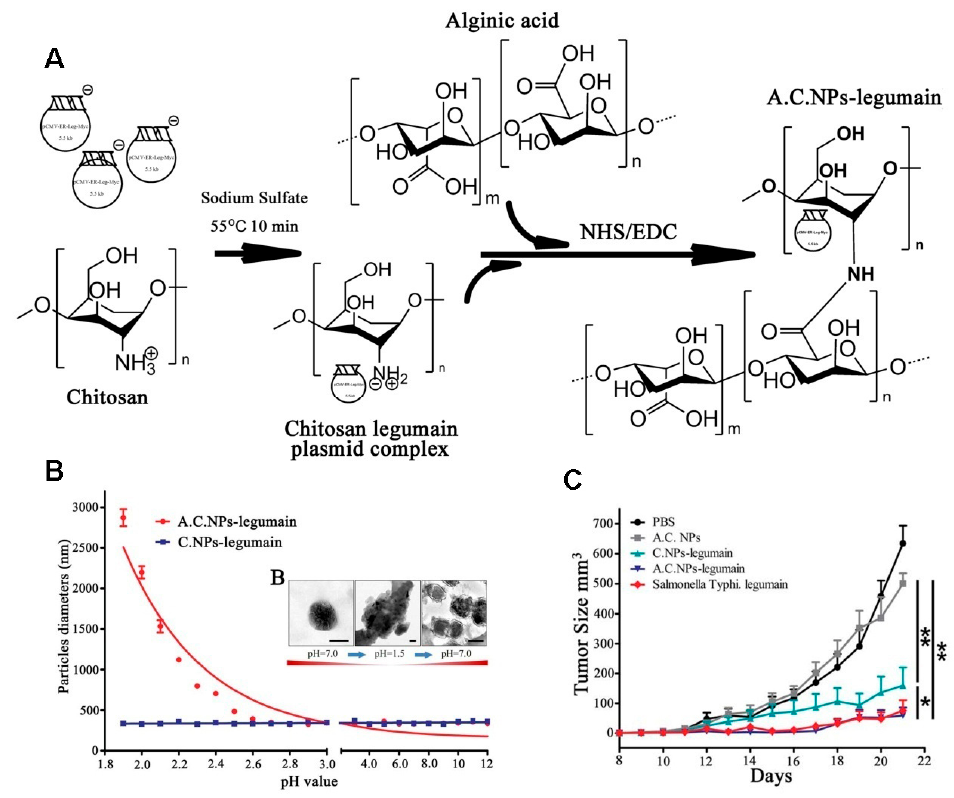
Figure 18. ( A ) Illustration of AC NPs-legumain synthesis; ( B ) Nanoparticles were treated in different acidity levels (pH 1.8, 12) for 2 h: A C NPs-legumain and A C NPs-legumain particle diameter and zeta potential measurements at 37 °C; ( C ) Tumor growth curves. Data are presented as mean ± SD (* p < 0.05, ** p < 0.01) [65].